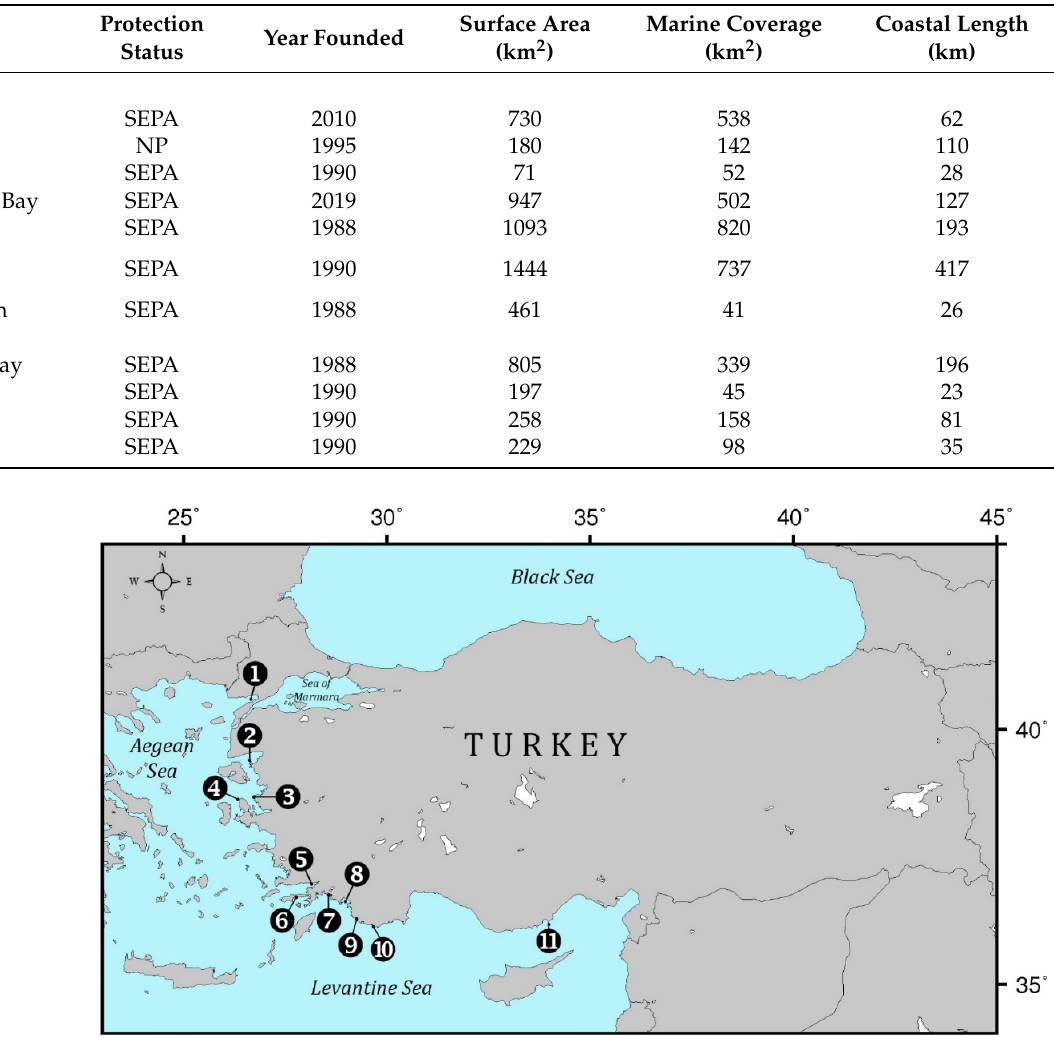
Table 1. General information on studied MPAs of Turkey (NP: national park, SEPA: special environmental protection area).